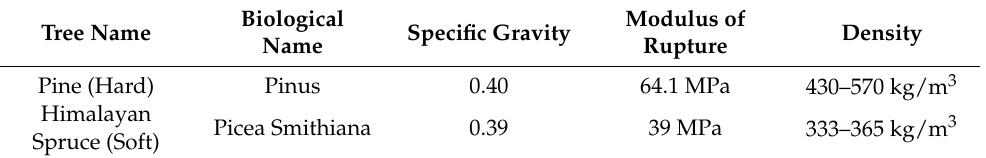
Table 2. Wood-related